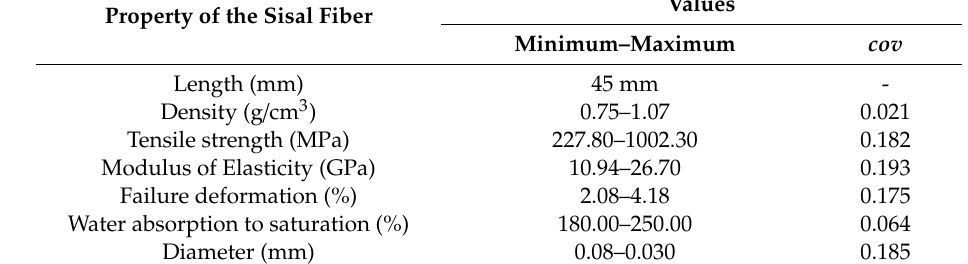
Table 3. Properties of sisal fiber.